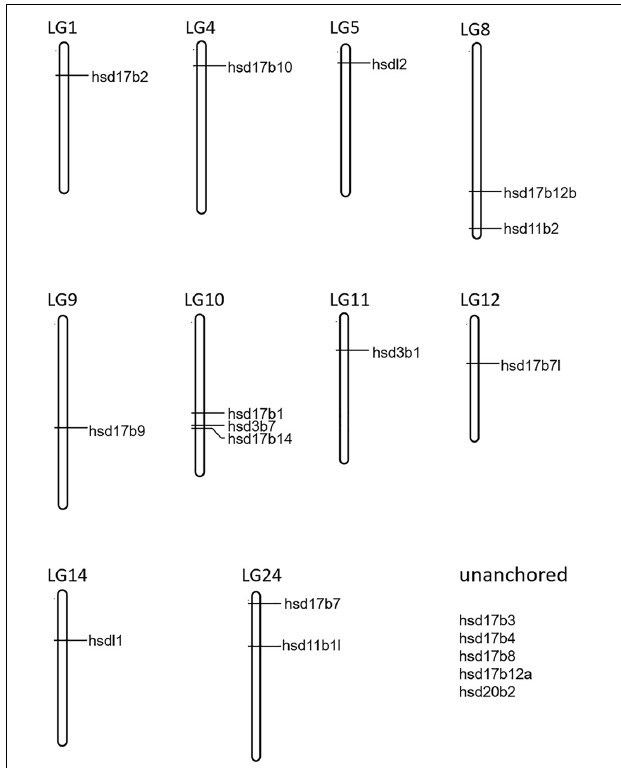
FIGURE 1 | Chromosome localization of 19 β -hsd genes from orange-spotted grouper.